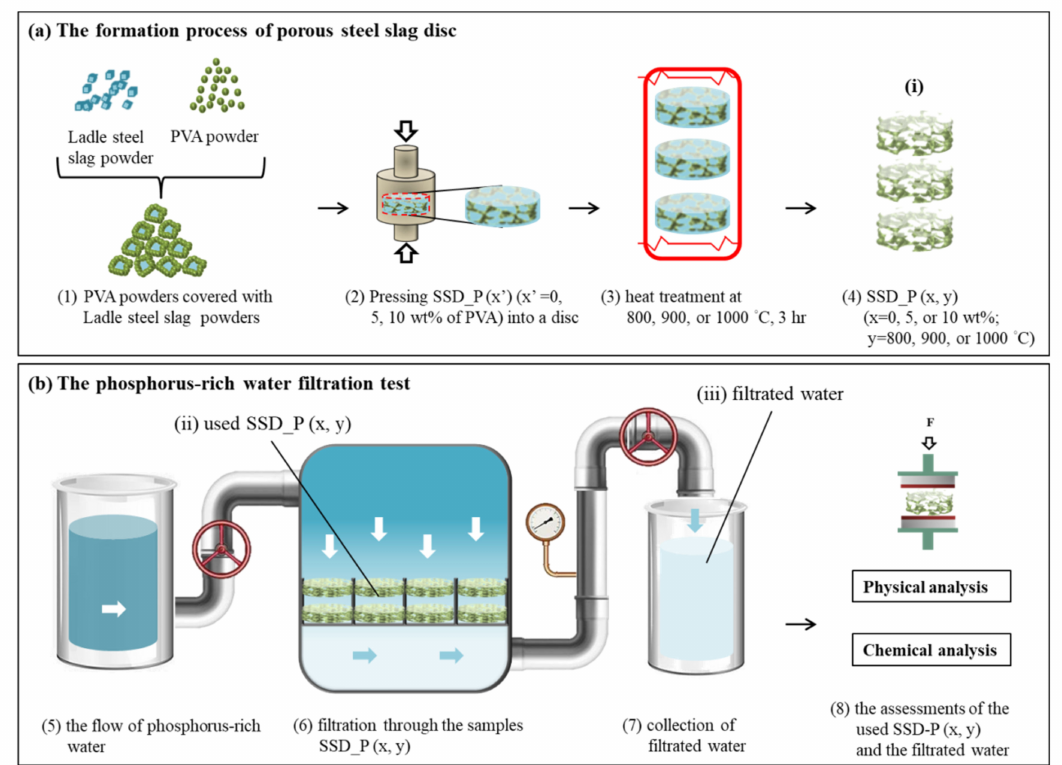
Figure 1. ( a ) The formation process of porous steel slag disc (SSD_P): (1) mixing Ladle steel slag powder with 0, 5, 10 wt% of PVA powder; (2) pressing SSD_P (x’) (x’ =0, 5, 10 wt% of PVA) into a disc; (3) SSD_P (x’) was followed by heat-treated at 800, 900, or 1000 ◦ C for 3 h; (4) the as-heated samples were denoted as SSD_P (x, y) (x = 0, 5 or 10%, y = 800, 900 or 1000 ◦ C). ( b ) The P-rich water filtration test: (5) the flow of P-rich water; (6) the filtration process through SSD_P (x, y); (7) the collection of filtrated water; (8) the examinations of the used SSD-P (x, y) and the filtrated